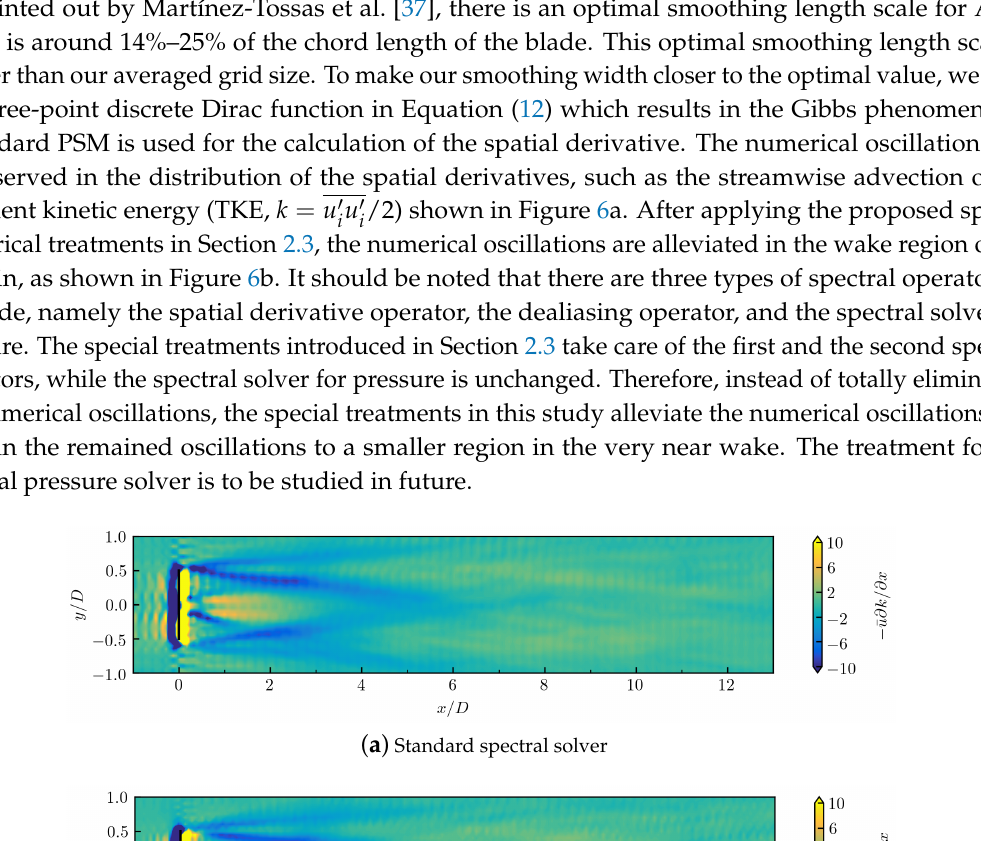
Figure 5. The grid discretization for fluid and turbine in y The red lines inside the turbine geometry are actuator line elements.